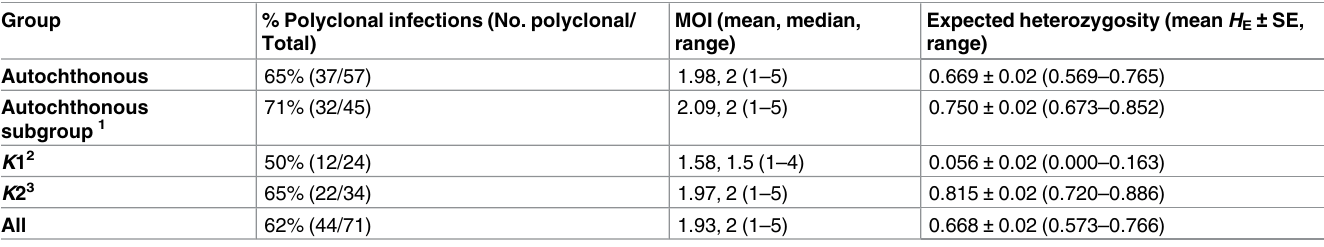
Table 3. Complexity of infection and population